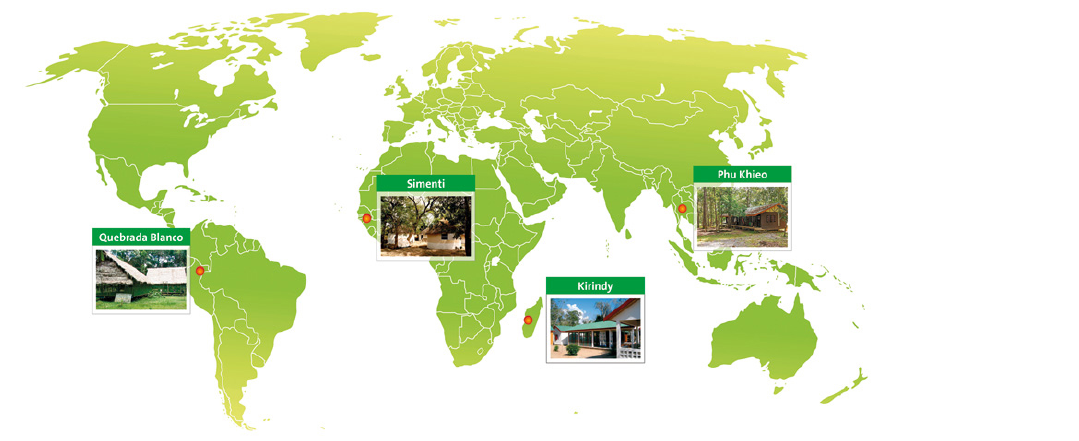
Figure 3. DPZ is unique, as it runs running field research sites in all major areas of primate distribution (map created by Heike Klensang. Source: Deutsches Primatenzentrum